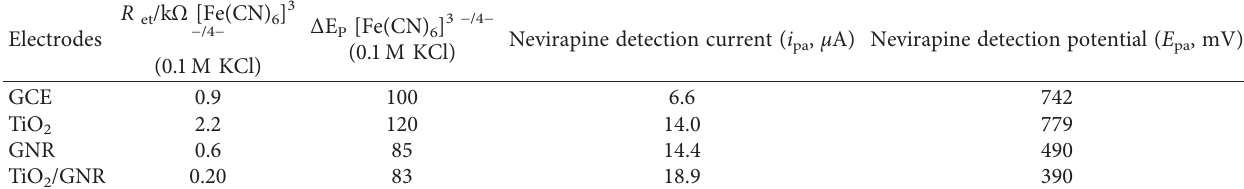
Table 1: Parameters for modified